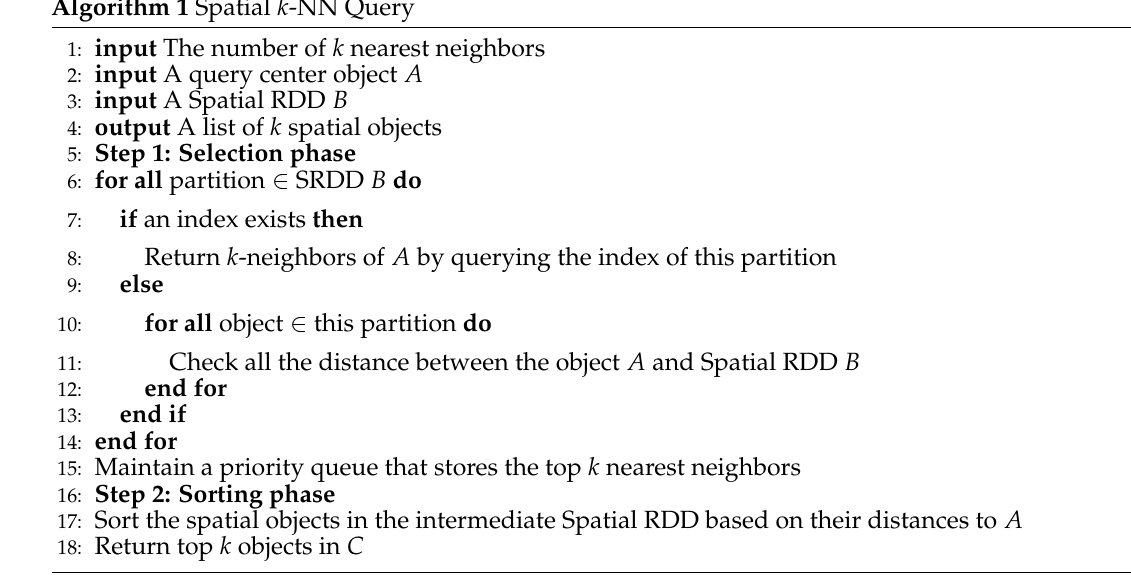
Algorithm 1 Spatial k -NN